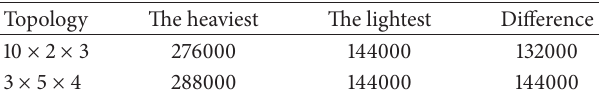
Figure 6: The model of the microstrip antenna array. Table 4: Comparisons of communication